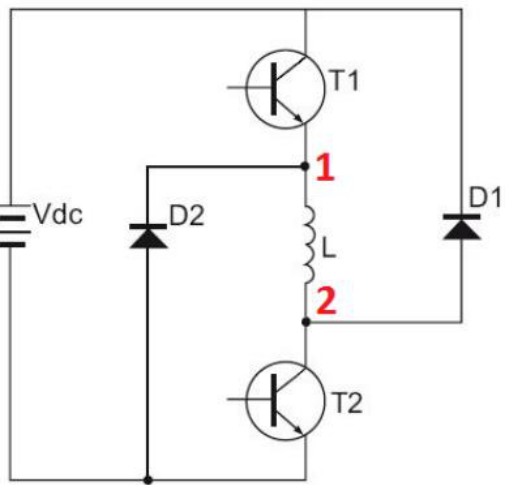
Figure 8. A power converter for controlling one phase band, where Vdc is the DC voltage source, T1 and T2 are the transistors connected by the control circuit, D1 and D2 are the diodes, and L is the motor phase band.